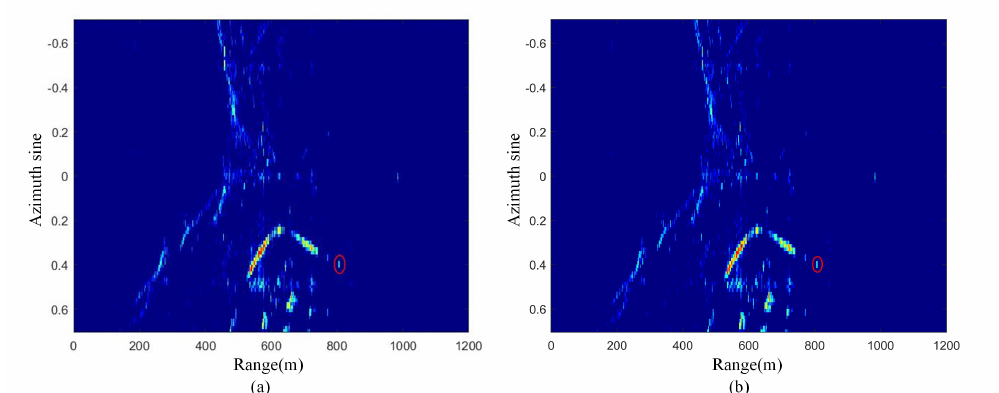
Figure 17. Imaging results of measured data. ( a ) Imaging results based on interpolation method. ( b ) Imaging results of the method proposed in this